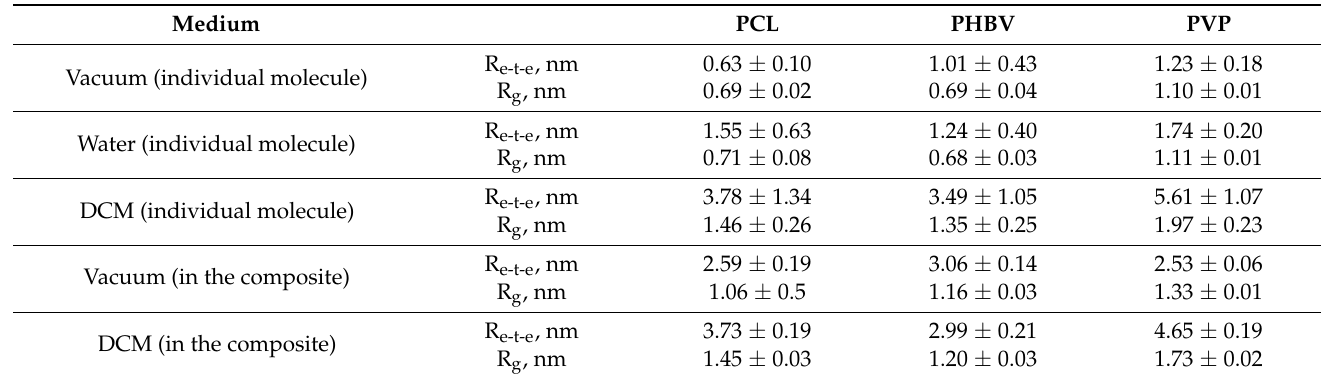
Table 10. The end-to-end distance R e-t-e and radius of gyration R g of the polymers (as individual macromolecules and as a part of the composite) in vacuum, water, and DCM.